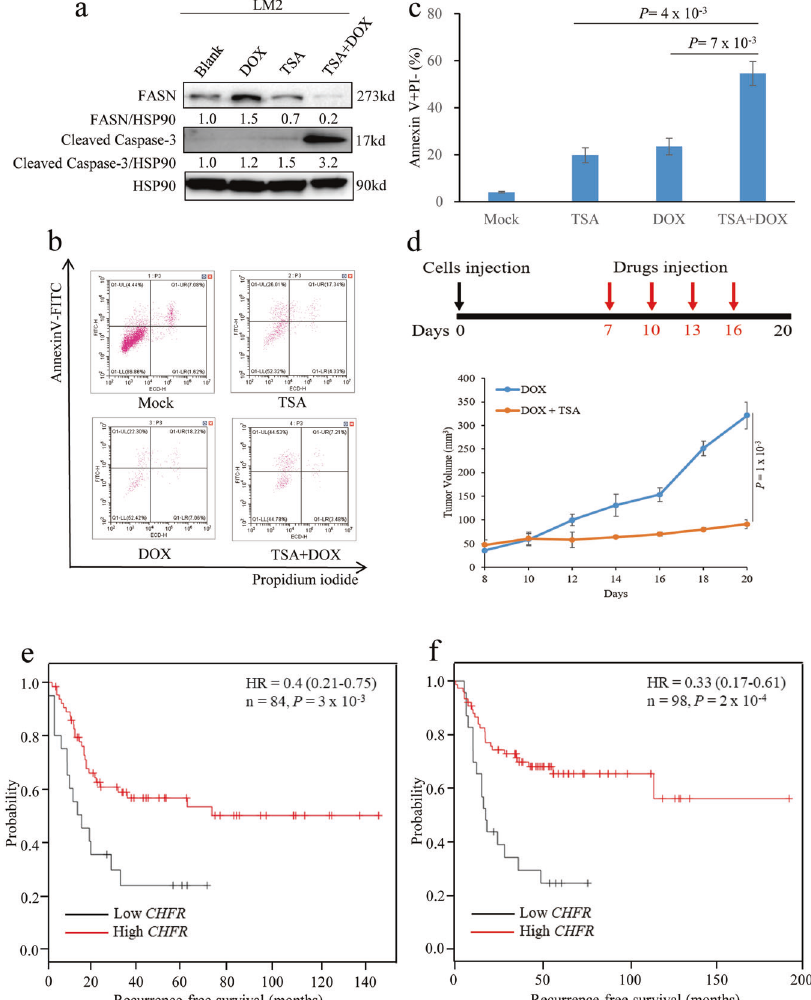
Fig. 7 CHFR promotes apoptosis and correlates with good clinical outcome in malignant breast cancer. a LM2 cells were treated with or without DOX and TSA as indicated and immunoblotted with the FASN, Cleaved Caspase-3, and HSP90 antibodies. b , c SUM159 cells